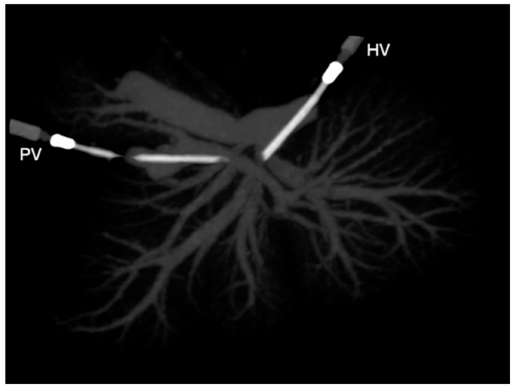
Figure 2. Ventrodorsal view on a maximum-intensity projection (MIP) of a liver cast. HV, catheter to the hepatic vein; PV, catheter to the portal